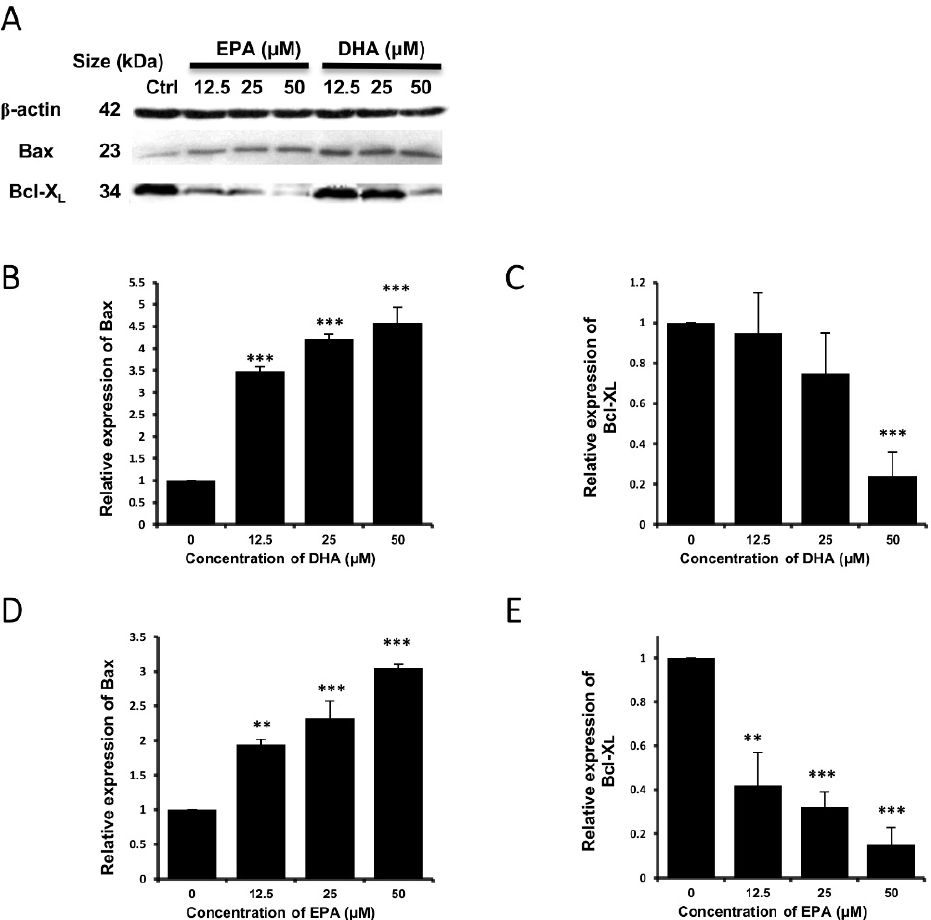
Figure 6. Effects of DHA and EPA on the expression levels of apoptosis-regulatory proteins in LA-N-1 cells. ( A ) LA-N-1 cells were incubated with various concentrations of EPA (Lanes 2, 3 and 4) or DHA (Lanes 5, 6 and 7) for 48 hours. Cells treated with ethanol (Lane 1) acted as the control. The protein expression levels of Bax, Bcl-X L were measured by Western blotting with β-actin serving as an internal control. The relative protein expression levels of Bax and Bcl-X L in DHA-treated cells ( B , C ) and EPA-treated cells ( D , E ) as compared to β-actin were quantified. The results are expressed as relative protein expression levels ± SD. ** p < 0.01, *** p < 0.001.